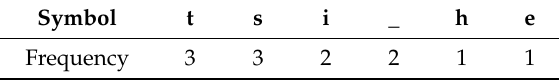
Table 1. Frequencies of letters in ‘this_is_test’ text.